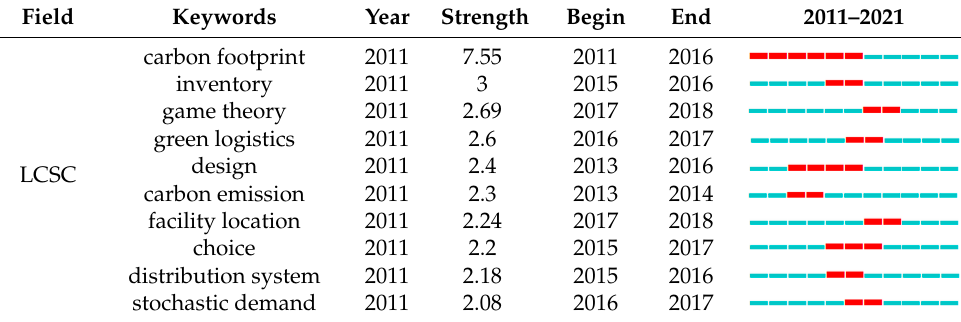
Table 10. Top 10 keywords ranked by burst detection.